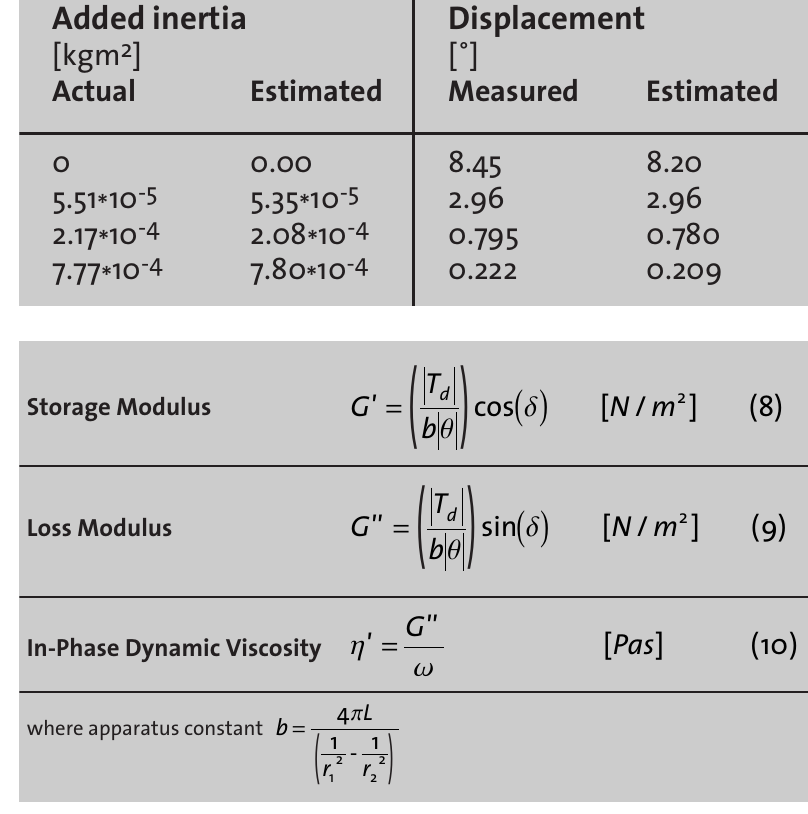
Table 1 (above): Self-sensing performance results. Table 2 (below): Rheological